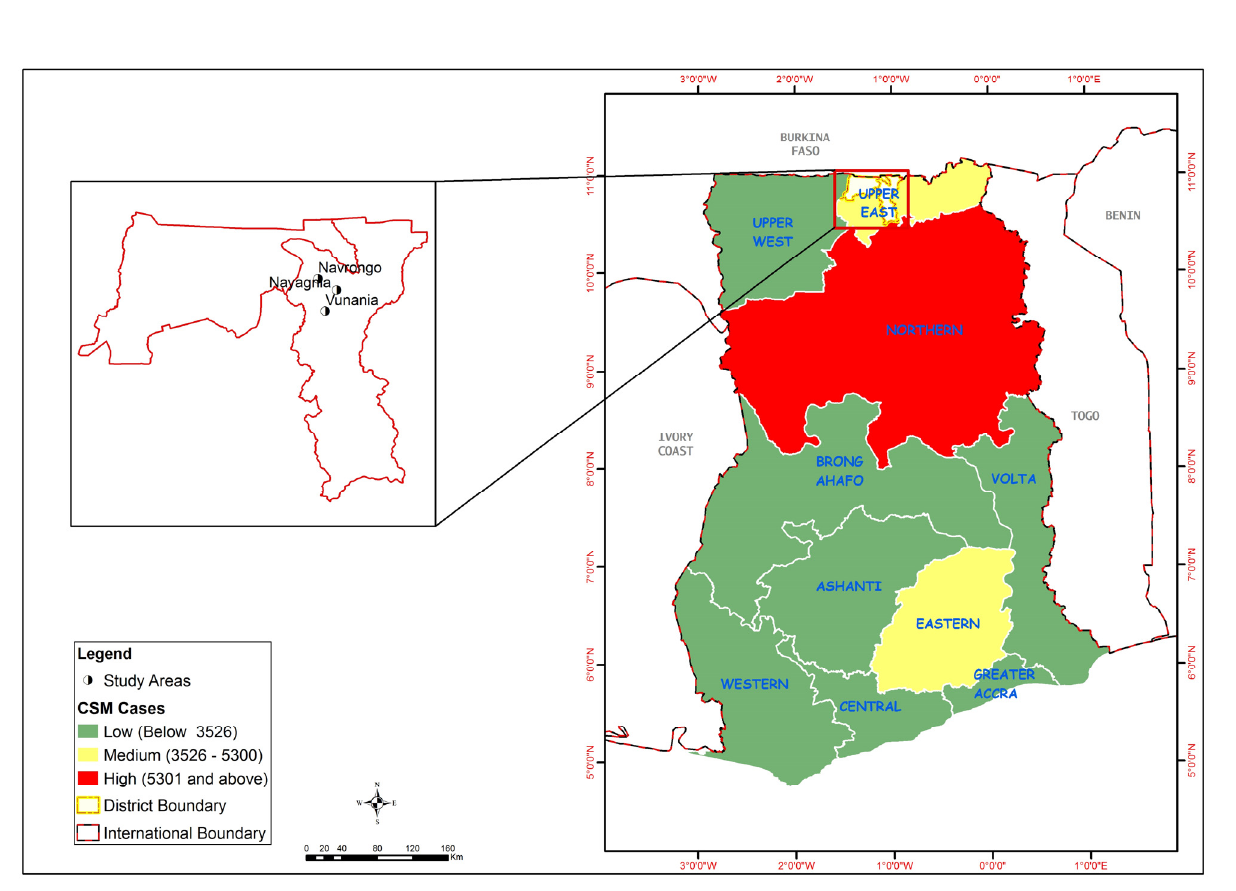
Figure 1. Map of Ghana showing regional distribution of recorded CSM cases, 1985–2008, and the study